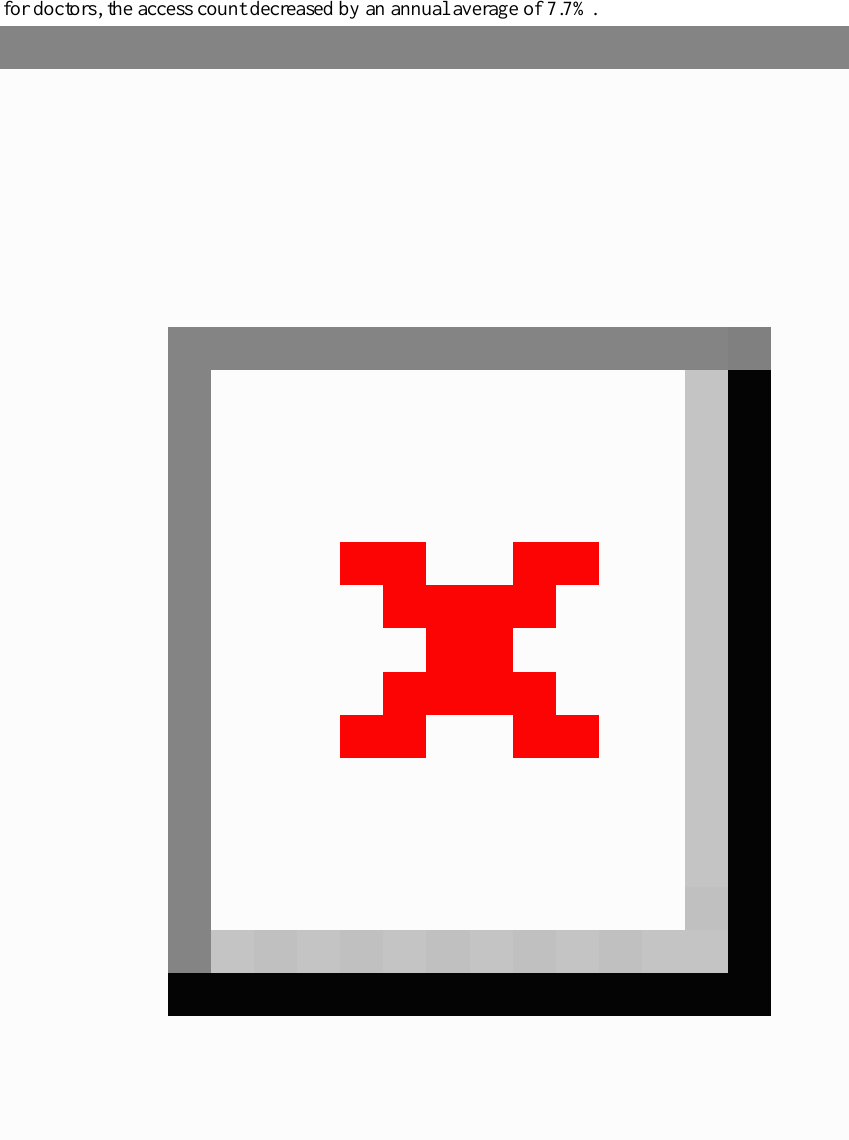
Figure 4 indicates that the peak use time differs in the case of doctors and nurses. Specifically, we analyzed the usage rates according to the time of the day and found that the peak usage periods were different for each occupation (Table 1; Figure